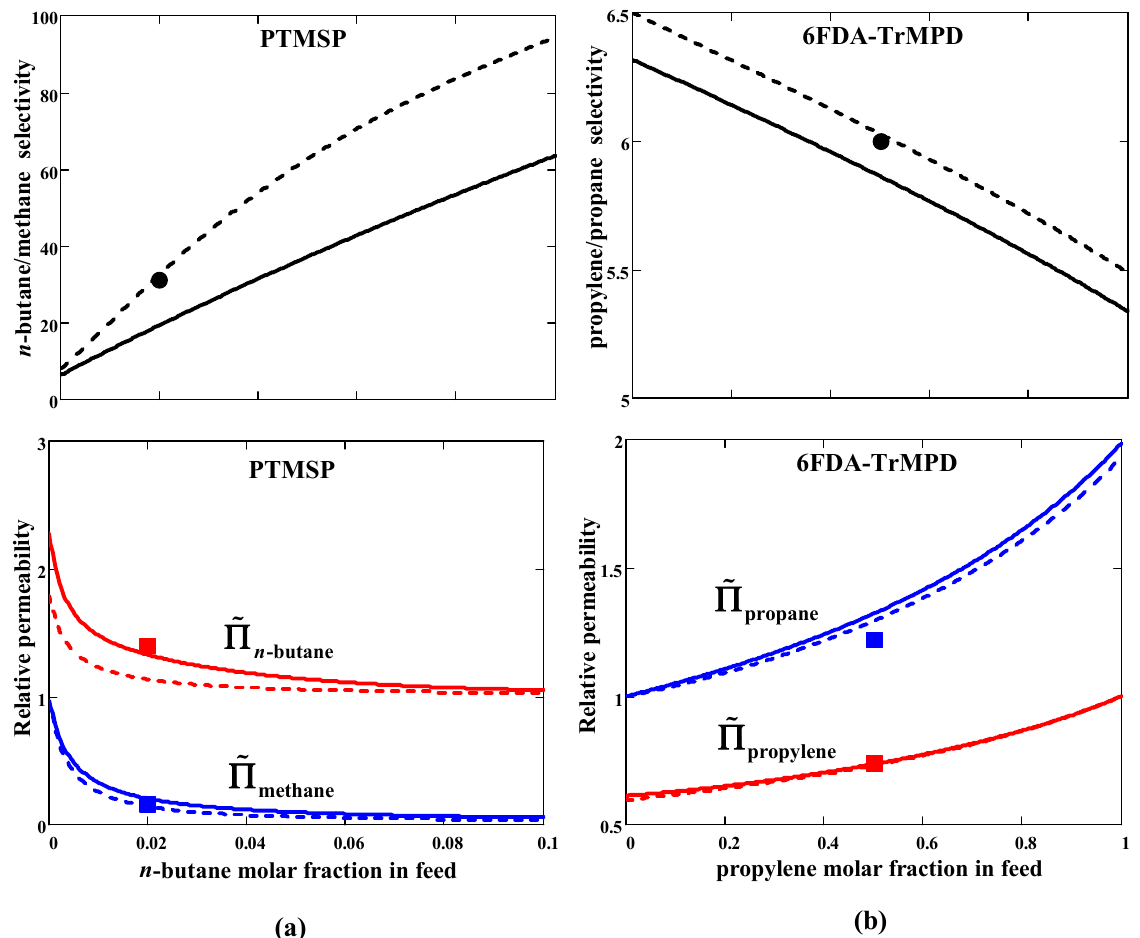
Figure 3. ( a ) Mixed-gas n -C 4 H 10 /CH 4 selectivity and relative permeabilities of the mixture components through PTMSP membrane versus n -C 4 H 10 feed molar fraction; ( b ) Mixed-gas C 3 H 6 /C 3 H 8 selectivity and relative permeabilities of the mixture components through polyimide 6FDA-TrMPD versus C 3 H 6 feed molar fraction. The results of selectivity and permeability calculations are given for pressure ratio r = 0 (solid lines) and r = 0.05 (dashed lines). Experimental selectivities and permeabilities for 2 mol % n -C 4 H 10 /98 mol % CH 4 /PTMSP and 50 mol % C 3 H 6 /50 mol % C 3 H 8 /6FDA-TrMPD systems are shown by the symbols.